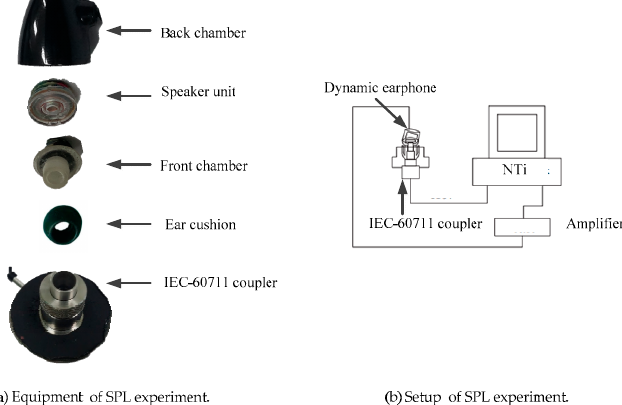
Figure 24. Equipment and setup of sound pressure level (SPL) experiment .